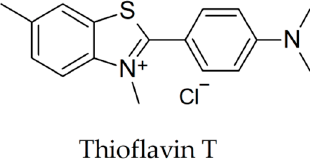
Figure 1. Chemical structure of thioflavin T.